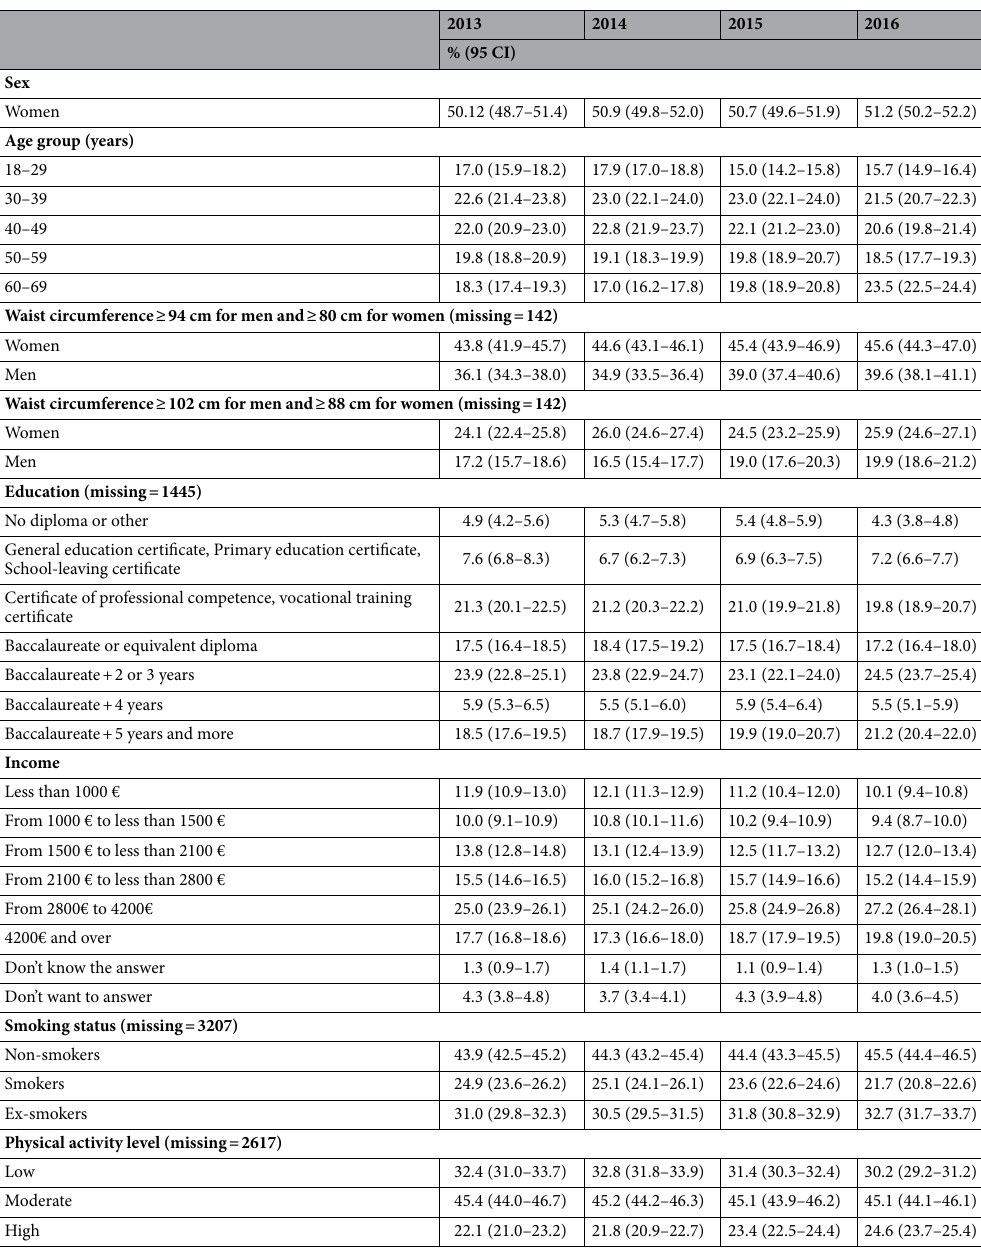
Table 1. Participants’ characteristics by survey year (N = 63,582). Estimates of prevalence are weighted at year of invitation to survey participation. Age and sex-adjusted by the raking ratio method using the Insee data